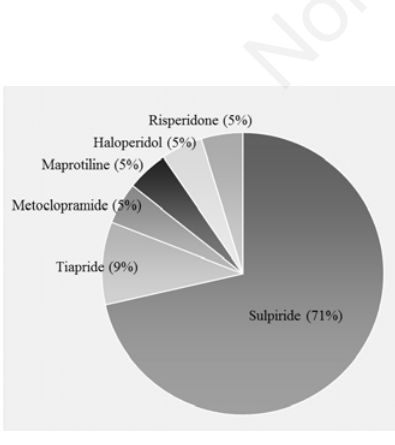
Figure 3. Based on clinical symptoms and neuroimaging findings, 11 of the 21 cases (52%) had no presence of neuromuscular diseases before DIP onset. The remaining 48% did, which included cerebrovascular diseases (28%; five vascular dementia, one higher-order dysfunction due to multiple cerebral infarction, and one hemiplegia), neurodegenerative diseases (14.3%; one Parkinson’s disease, one case of familial spastic paraplegia, and one case of geriatric dementia), and depression (4.8%) (A). Fifteen of the patients (71%) had a good outcome in that they were able to walk at home after withdrawal of the causative drug, but three were wheelchair-bound and one died from malignant syndrome (B).